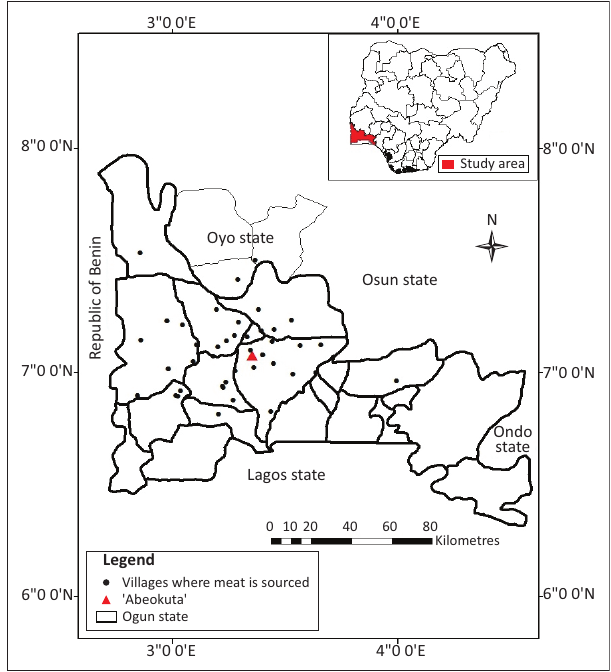
FIGURE 1: A map of Nigeria showing Abeokuta, Ogun State and the local villages and towns where games are sourced with its neighbouring states and the Republic of